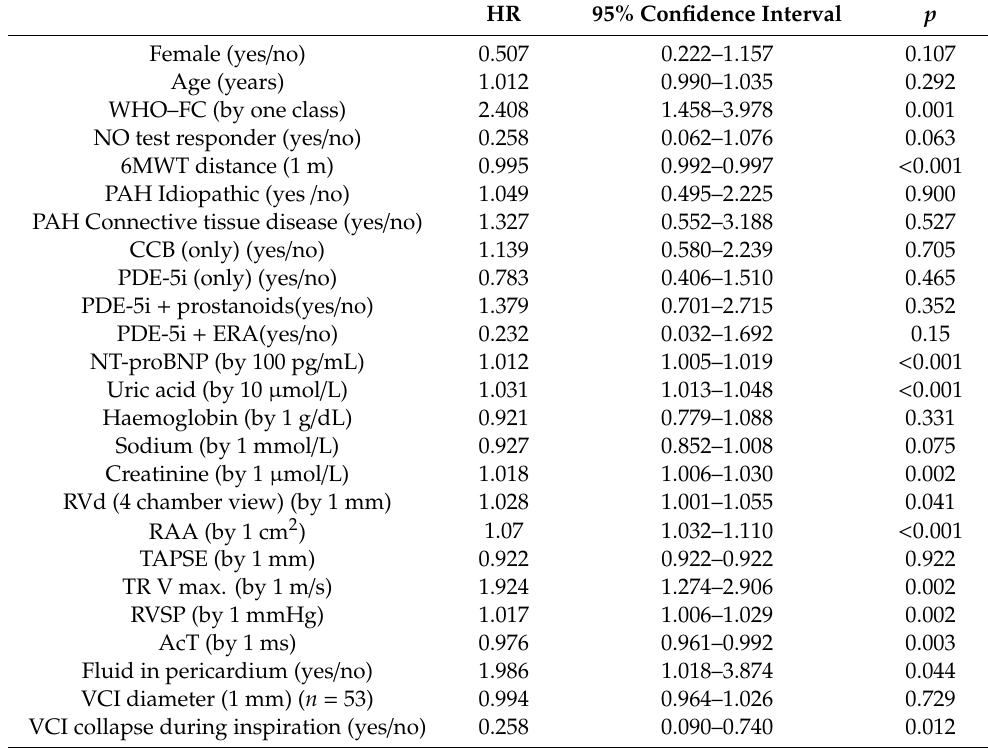
Table 4. Risk factors of death or lung transplantations in five-year follow-up. Univariable Cox regression analysis of clinical, echocardiographic and laboratory